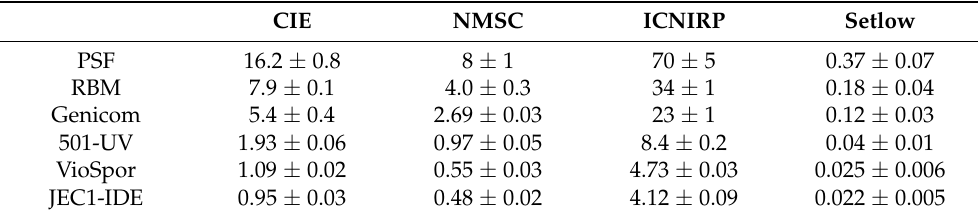
Table 3. Mean values with standard deviations of the ratios of measured to weighted UV doses for 2018. The r X ( λ ) ,CIE values in column two reflect the data given in Figure 5b. CIE